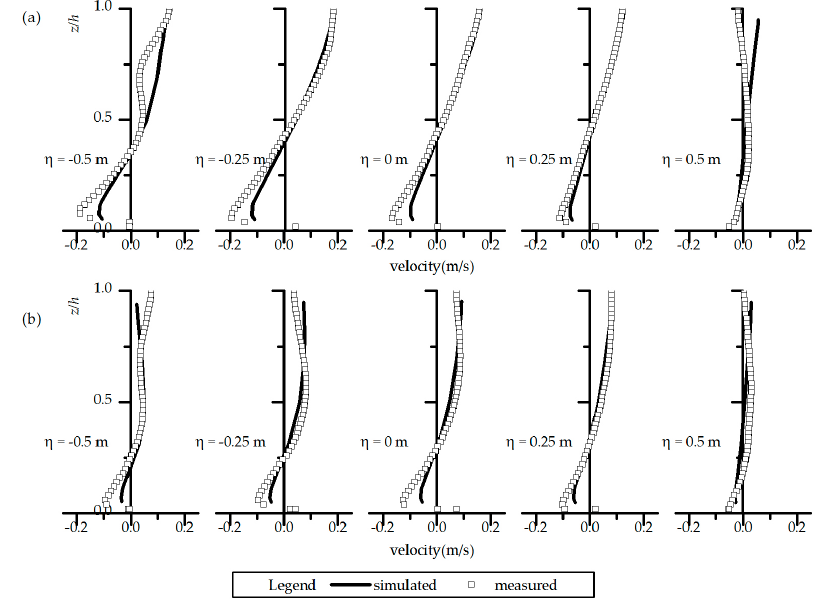
Figure 6. Calculated transverse velocity profiles in comparison with the measurements: ( a ) Cross-section 90°; ( b ) cross-section 180° . η is the position in the lateral direction from the central line towards the outer bank.